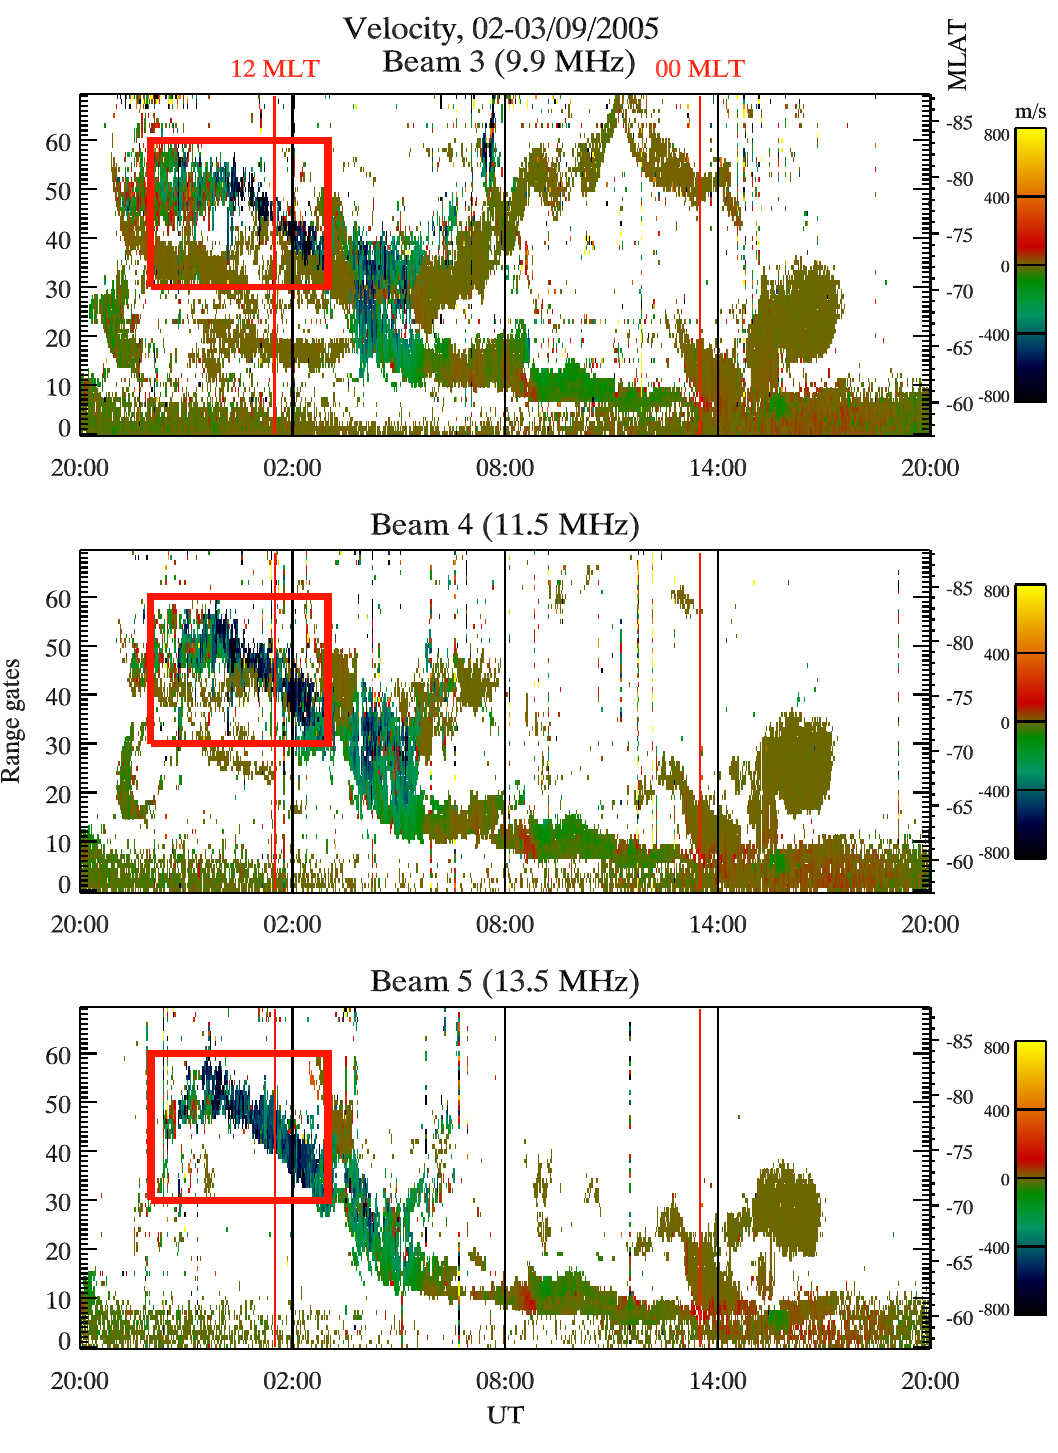
Fig. 3. The same as in Fig. 2 but for line-of-sight velocity.